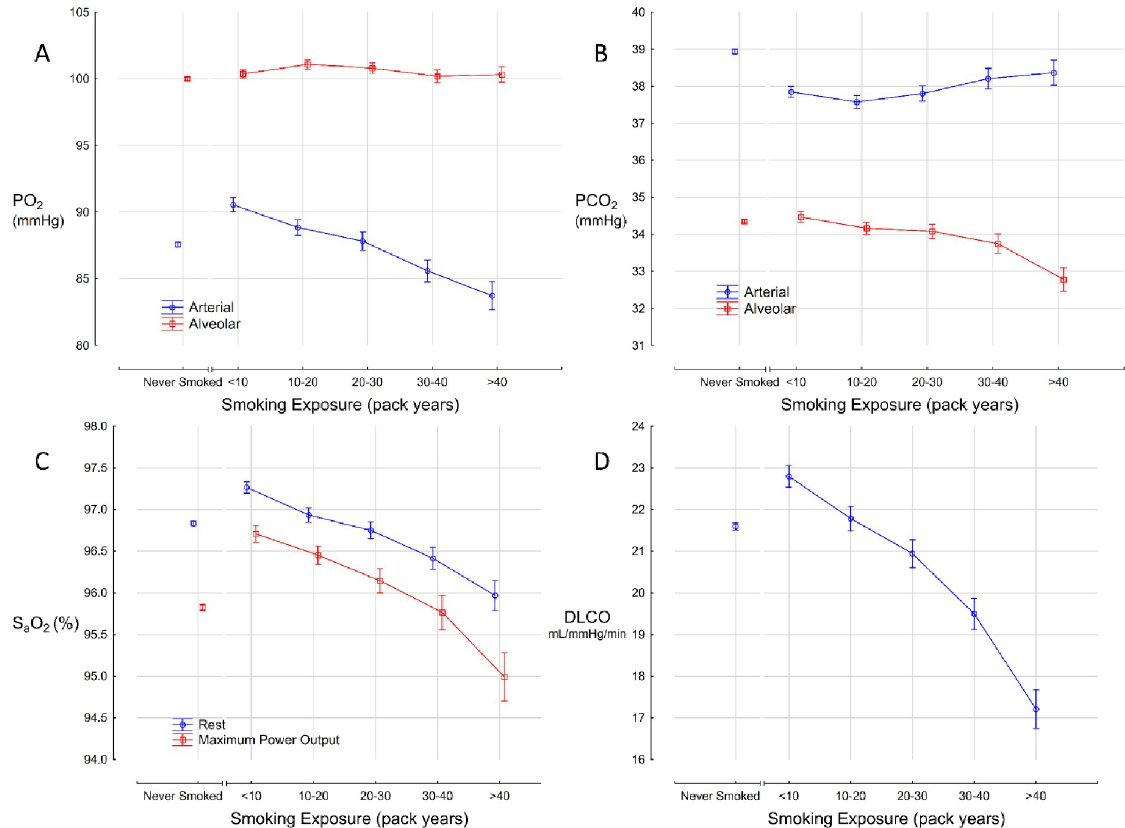
Fig 3. Effect of cigarette smoke exposure on the arterial-alveolar gradients for (A) oxygen and (B) carbon dioxide, (C) oxygen saturation, and (D) diffusion capacity.